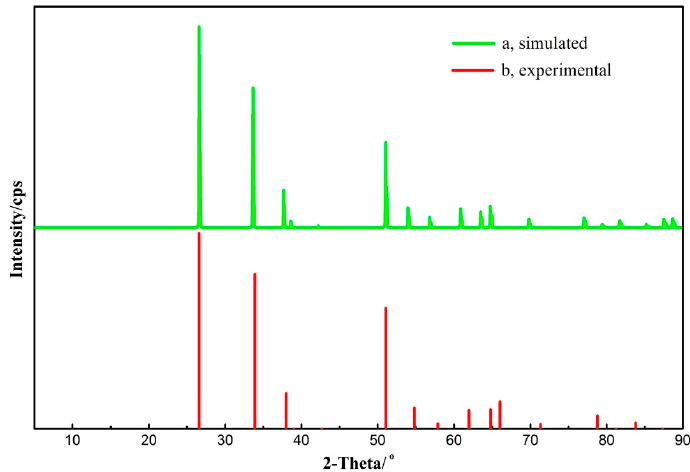
Figure 5. Contrast of the simulated ( a ) X-ray diffraction spectra with the experimental ( b ) one.